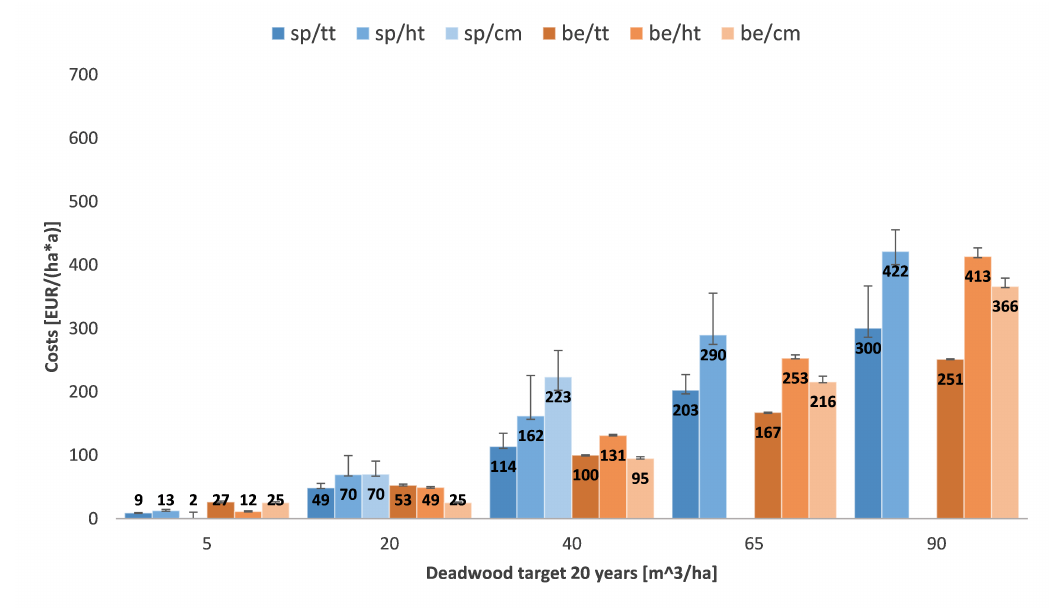
Figure 5. Forest enterprise “Neureichenau”: Costs in [ e ha − 1 a − 1 ] for target deadwood amounts in [m 3 ha − 1 ], to be maintained within 20 years. Blue columns show spruce ( sp ) and orange beech strategies ( be ). tt : Total tree, ht : Heavy timber, cm : Crown